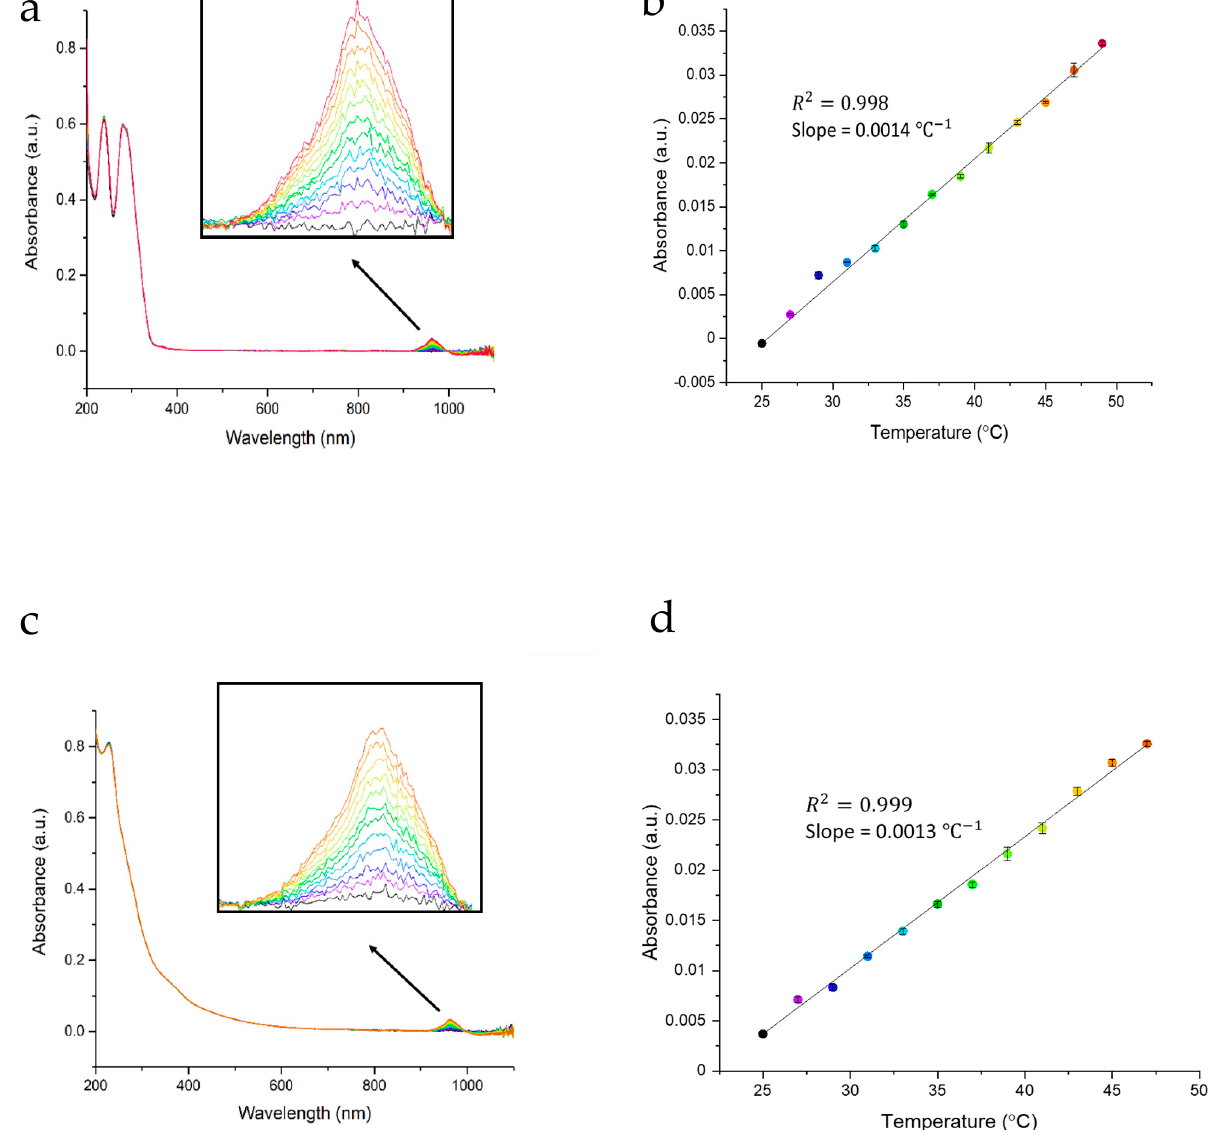
Figure 1. ( a ) N-GQDs absorbance vs. temperature, ( b ) N-GQDs near-infrared spectrum peak absorbance vs. temperature with a linear correlation of R 2 = 0.998, ( c ) RGQDs absorbance vs. temperature, ( d ) RGQDs near-infrared spectrum peak absorbance vs. temperature with a linear correlation of R 2 = 0.999.